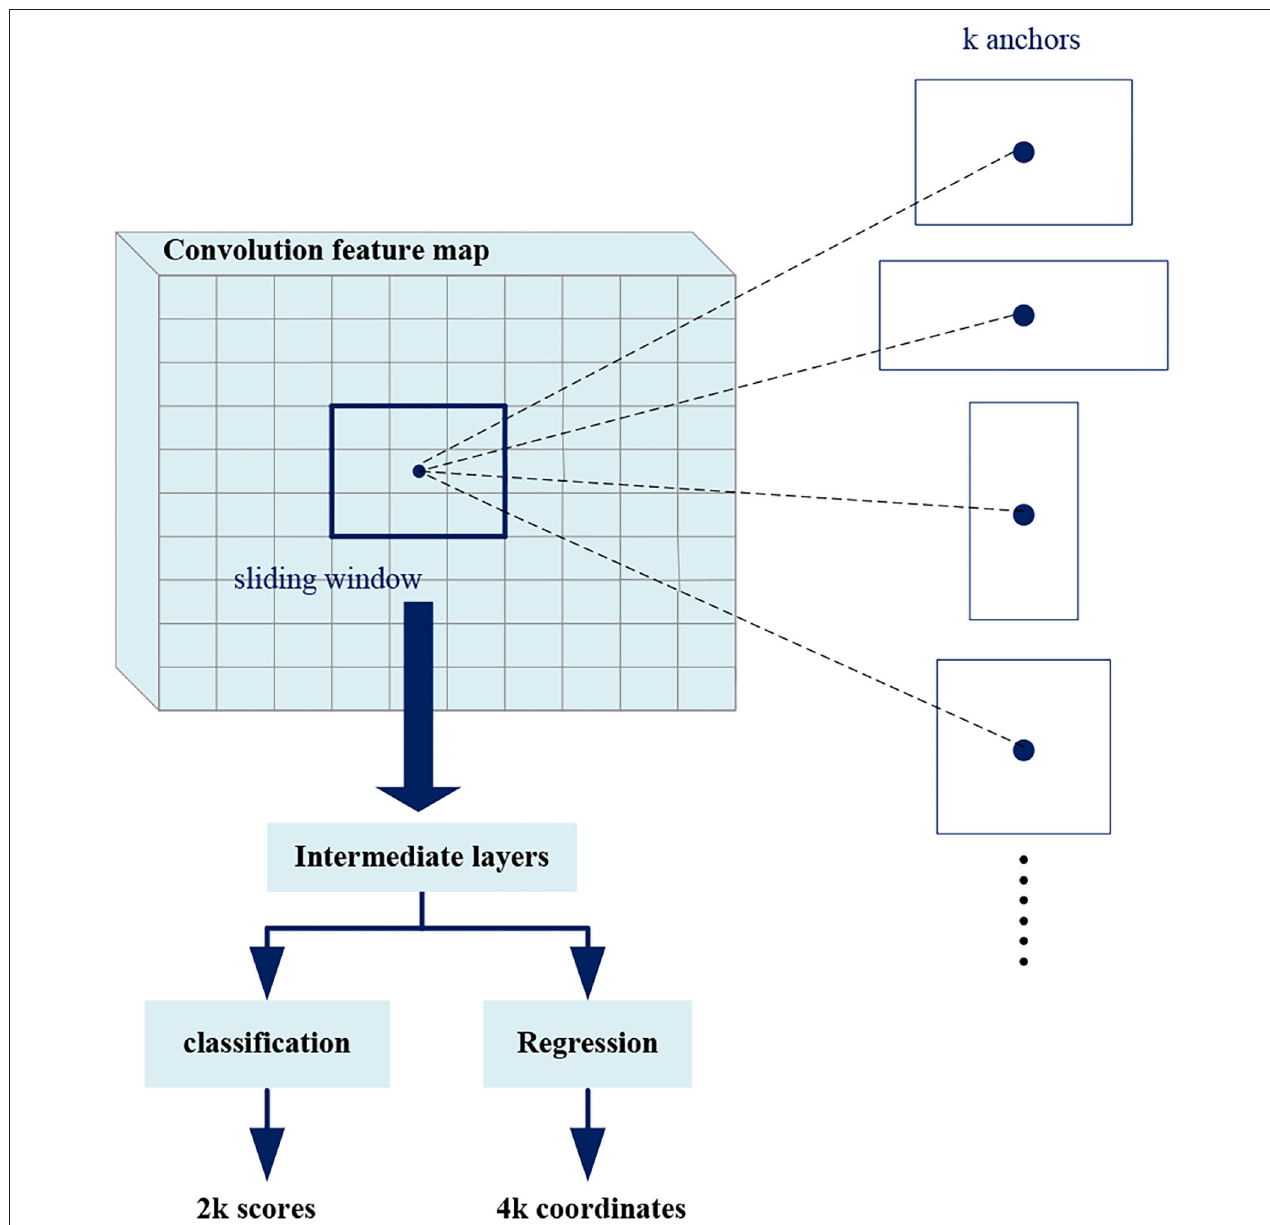
FIGURE 6 | Region proposal network